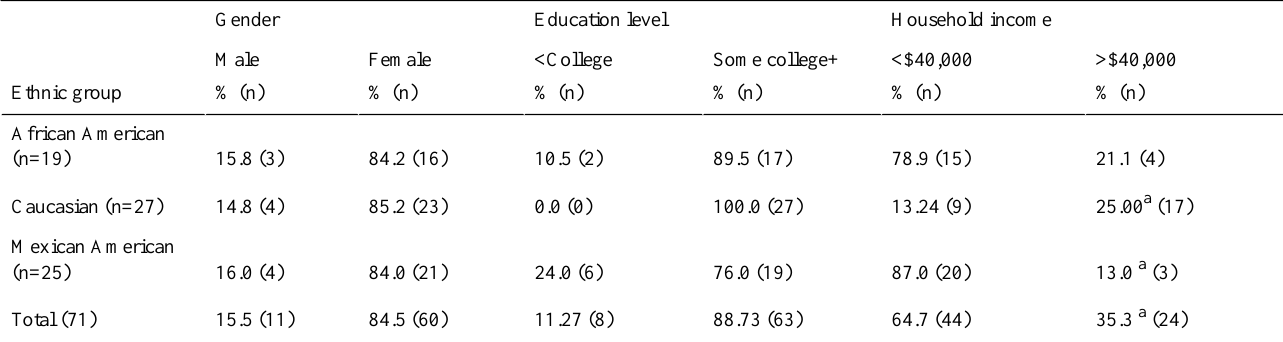
Table 1. Demographics of sample